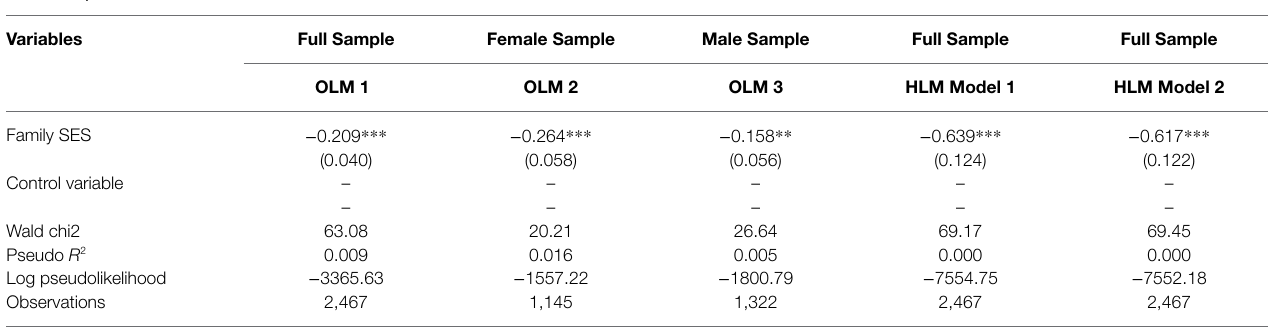
TABLE 5 | Results of robustness